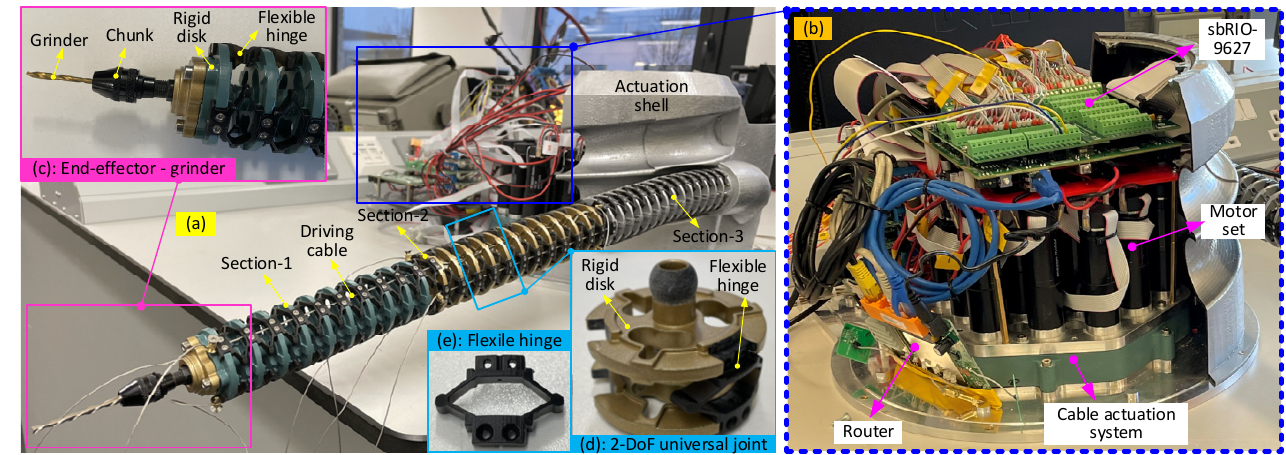
Figure 12. Experimental setup for demonstrating the collaborative operation algorithm: ( a ) is the overall operation setup of the dual-arm continuum robot; ( b ) is the actuation system (i.e., motor units, controllers, and communications); ( c ) shows the arrangement of the cutting tool; ( d ) and ( e ) are the 2-DoF universal joint and flexible hinge, respectively.